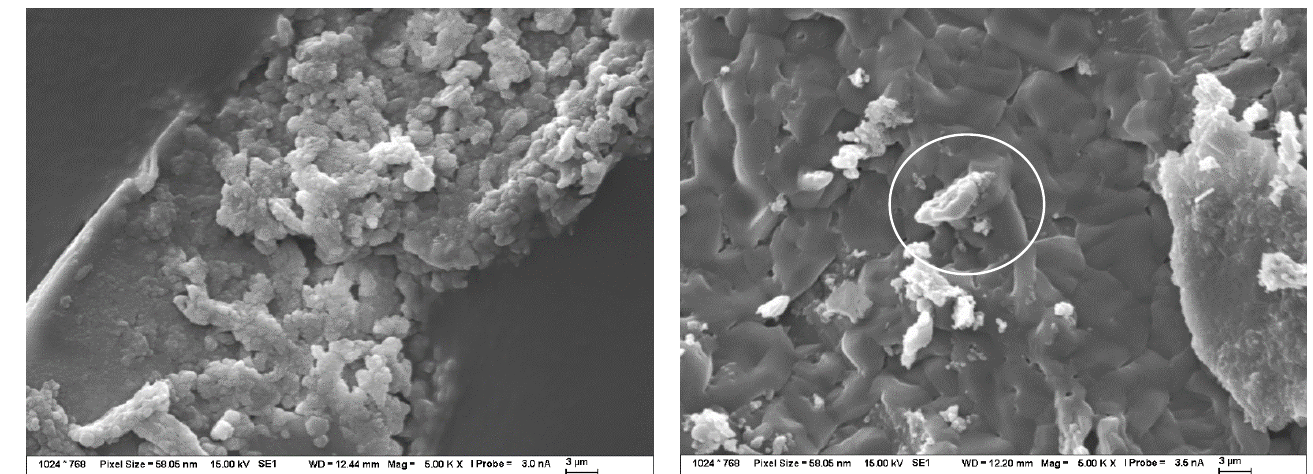
Figure 9. Structure of TS after 120 days of exposure in 1 mol/L NaOH solution at 40 °C, observed by SEM. The images show the very fine structure of the new CASH gel without crystalline products (marked by white circle). (marked by white circle).